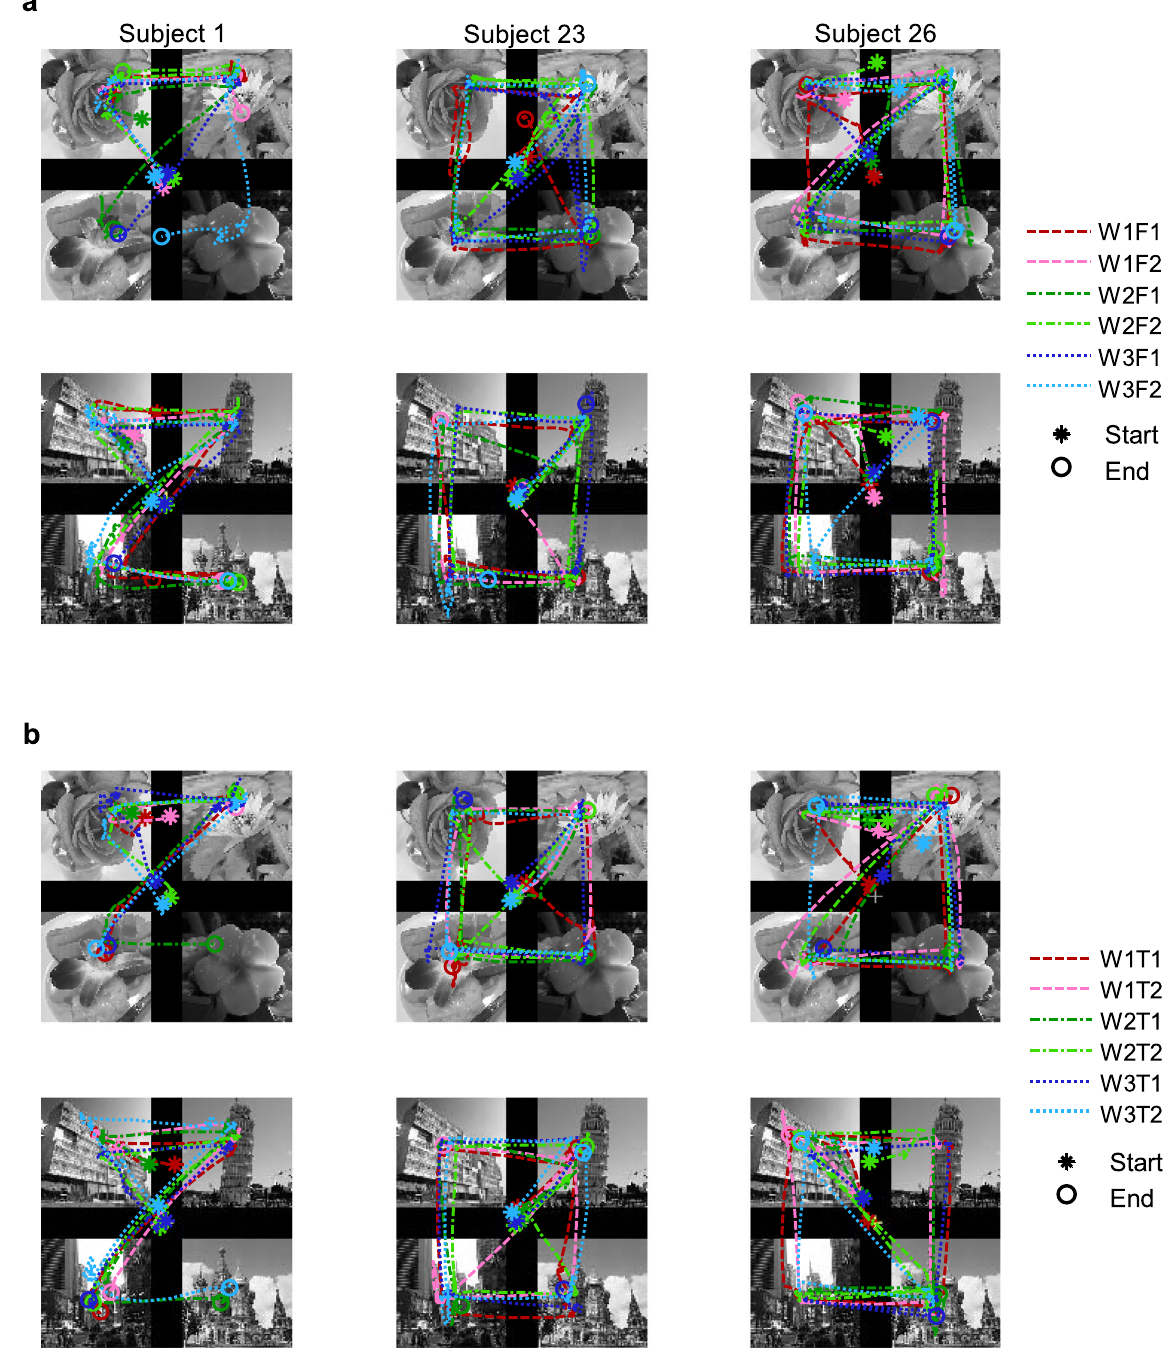
Figure 2. Scanpath examples. Examples of scanpaths in a 2D coordinate system for ( a ) Free sessions and ( b ) for Task sessions. The starting point of each scanpath is marked with an asterisk ( * ) and the end point with a circle (o). Each subject’s scanpaths during observations of an image set are plotted together on the image